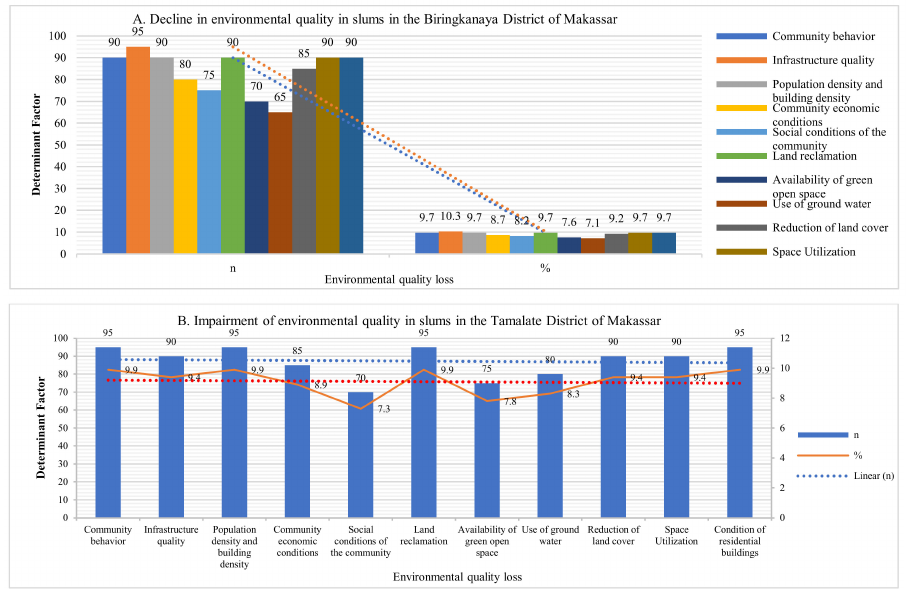
Figure 9. Declining quality of slum settlement environment ( A ) Biringkanaya and ( B ) Tamalate Districts in Makassar. Source: Primary Data,